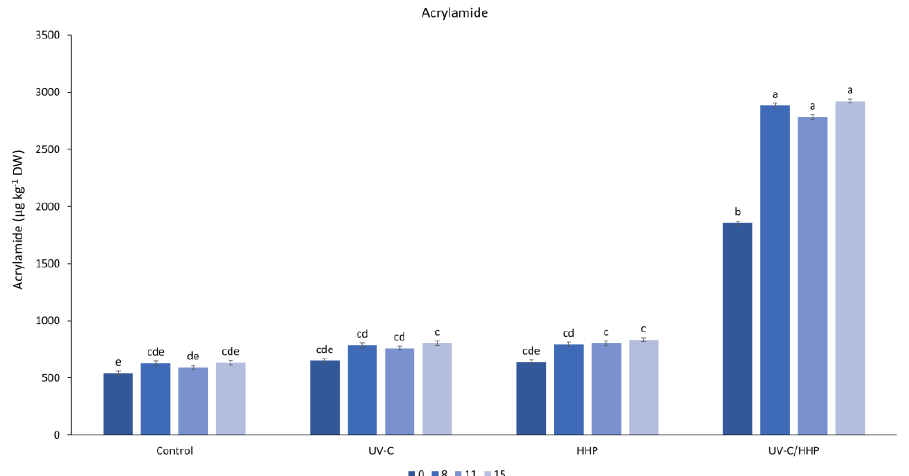
Figure 4. Interaction of treatment (control, UV-C, HHP, and UV-C/HHP) and storage time on acrylamide. Error bars represent standard errors; lowercase letters represent a significant difference within means ( p < 0.05).